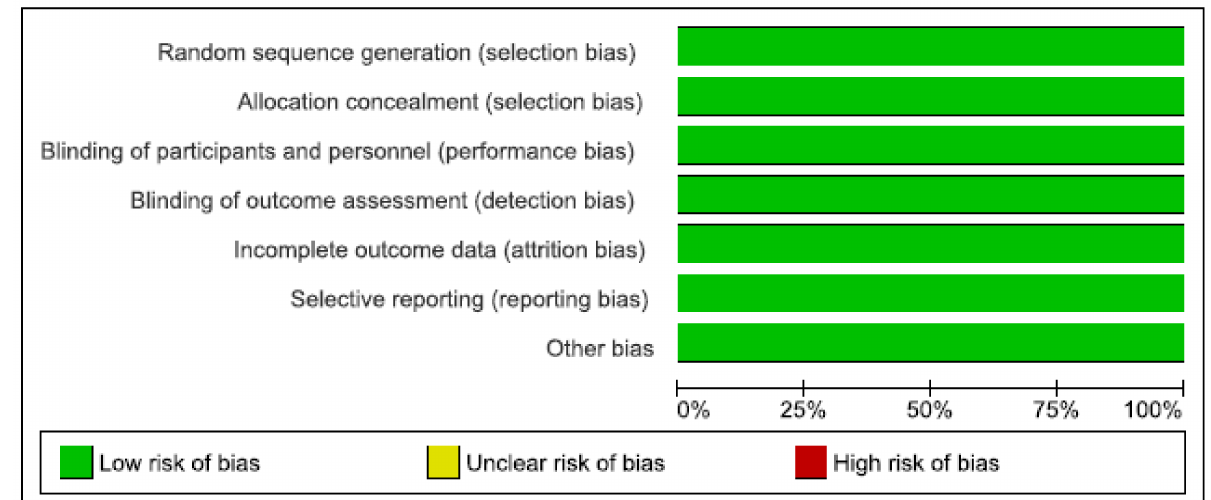
Figure 3. Summary of Risk of bias by domain.